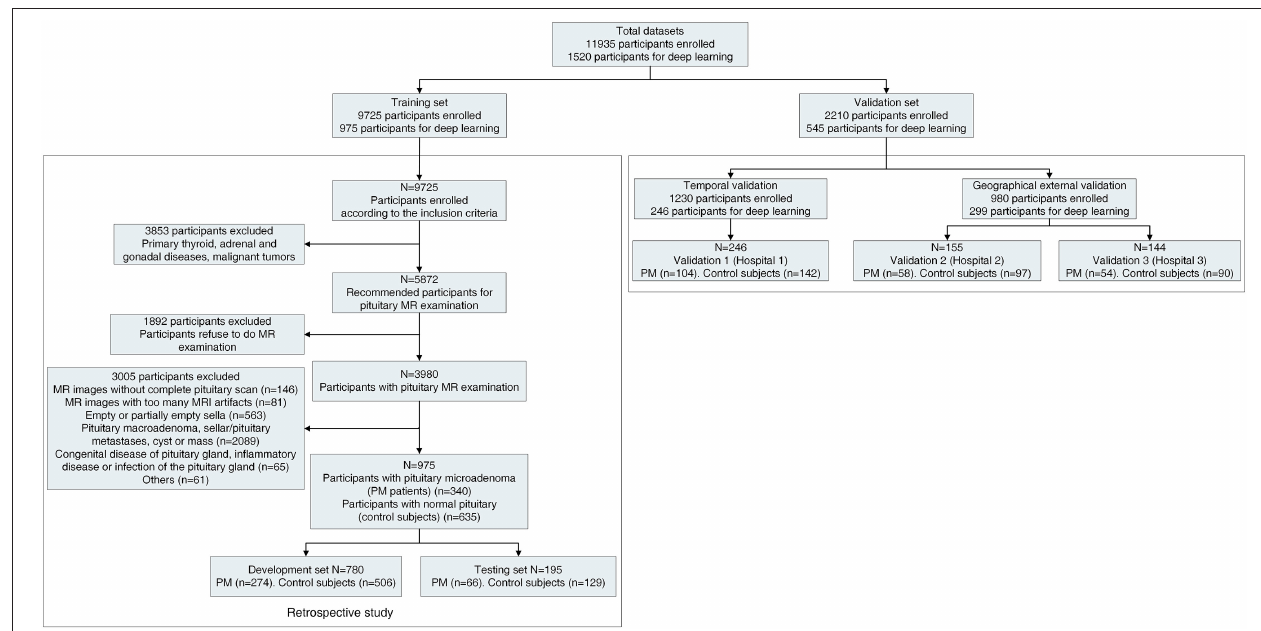
FIGURE 1 | Workflow diagram for the overall experimental design. The detailed workflow diagram of the validation datasets are in Supplementary Figure 2 . PM, pituitary microadenoma; MRI, magnetic resonance imaging. The Third Affiliated Hospital of Sun Yat-sen University as hospital 1. Sun Yat-sen Memorial Hospital of Sun Yat-sen University as hospital 2, and The Second Affiliated Hospital of Harbin Medical University as hospital 3.